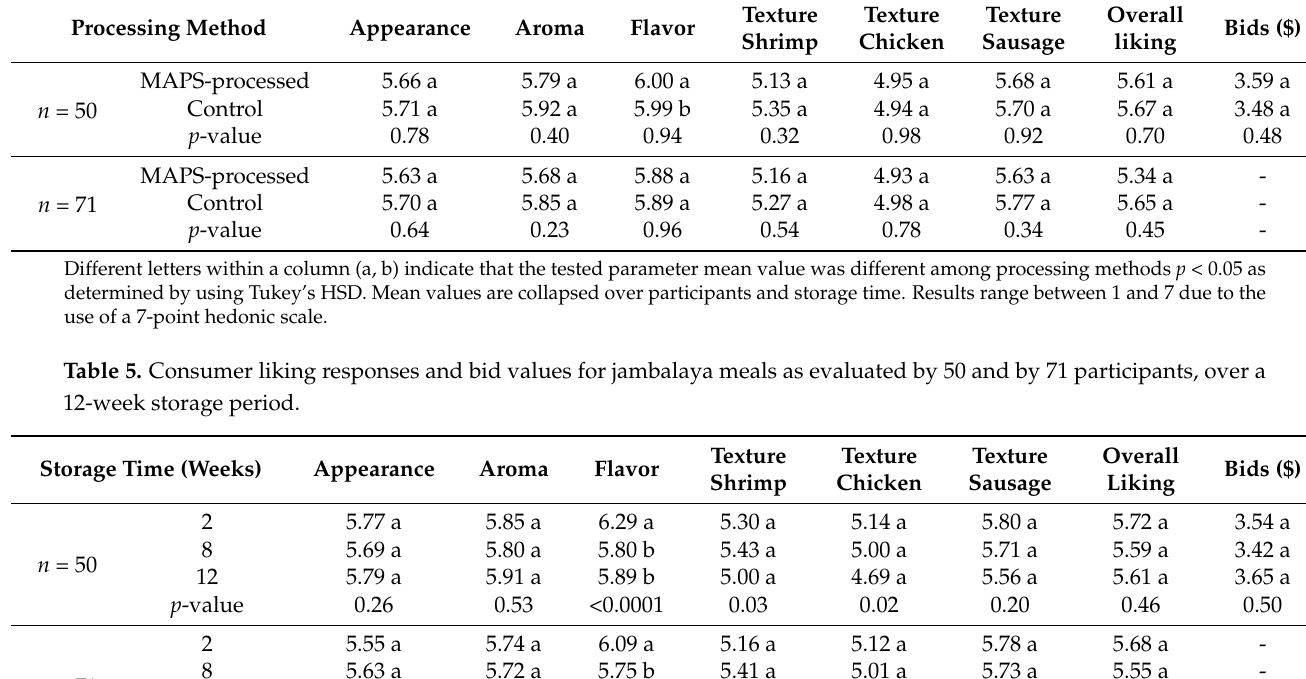
Table 4. Consumer liking responses and bids’ values for jambalaya MAPS-processed meals and a control (cooked and frozen meals) as evaluated by 50 and by 71 participants.